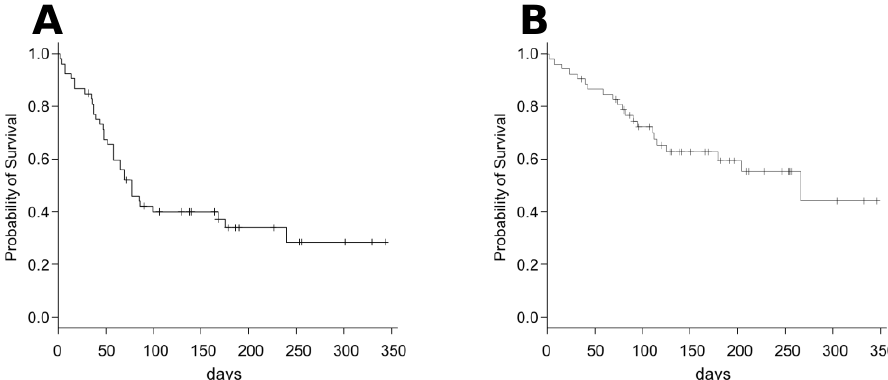
Figure 1. Survival curves after treatment with nivolumab in all patients: ( A ) progression-free survival; and ( B ) overall survival.